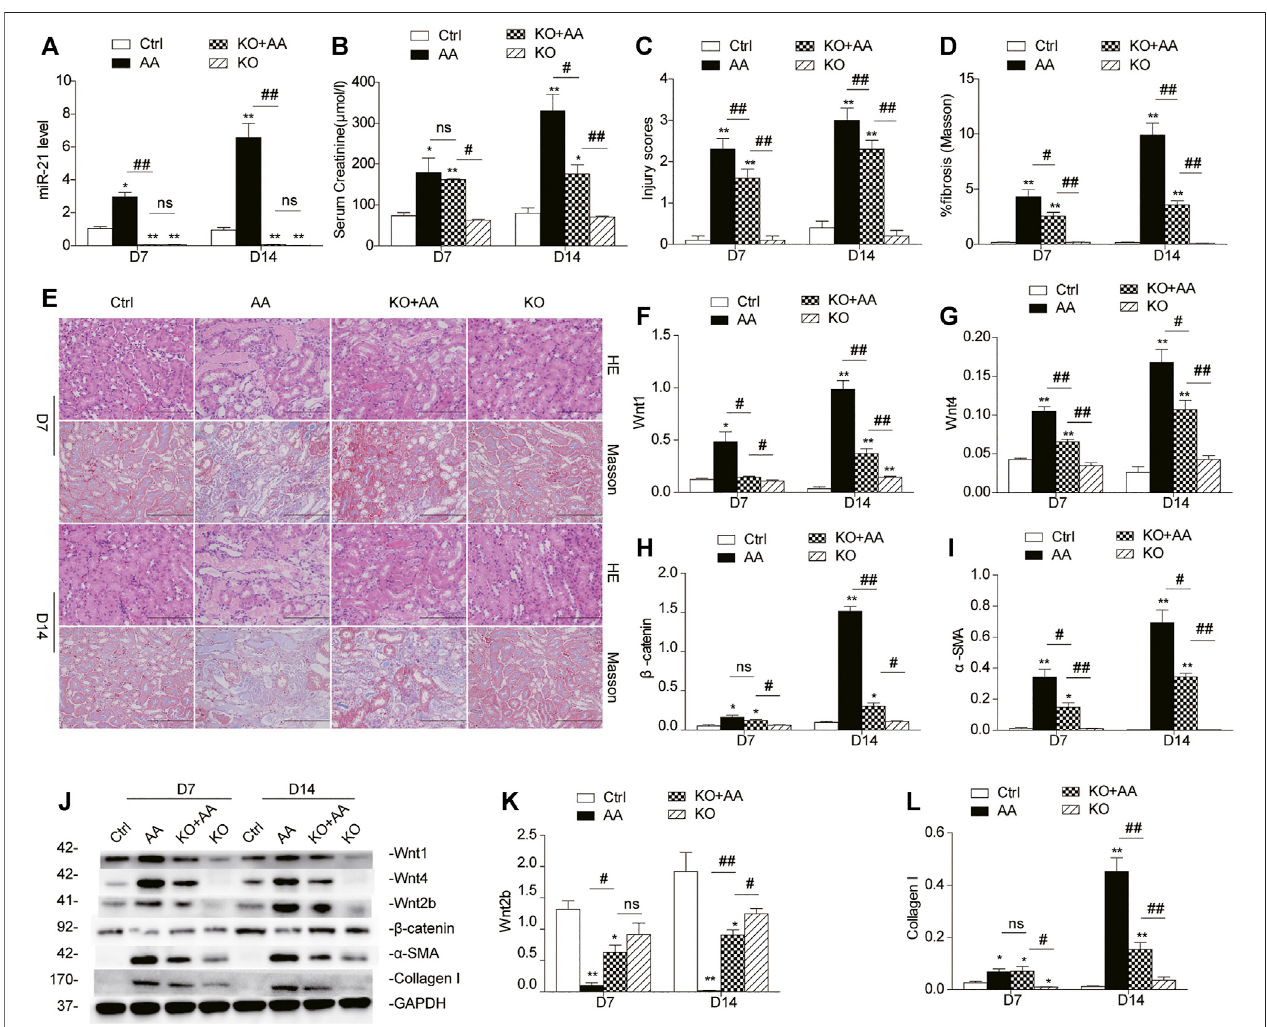
FIGURE 4 | Absence of miR-21 hinders AKI-to-CKD progression by selectively downregulating the Wnt/ β -catenin pathway. (A) Renal miR-21 abundance. The wild-typemice andmiR-21knockoutmice weresacri fi cedondays7and 14after AAadministration. (B) Serumcreatininelevelsofmice. (C) Kidneyinjuryscoresofmice on days 7and 14post AAdelivery. (D) Collagen abundance wasanalyzed using Masson ’ strichrome staining. (E) Renal histologicpatterns ofwild-typemiceandmir-21 KOmice(magni fi cation,200 × ,bar (cid:2) 200 μ m). (F – L) RelativeproteinexpressionofWnt1,Wnt4, β -catenin, α -SMA,Wnt2b,andcollagenIinkidneys.* p < 0.05,** p < 0.01 vs. controls. # p < 0.05, ## p < 0.01 vs. KO + AA, n (cid:2)